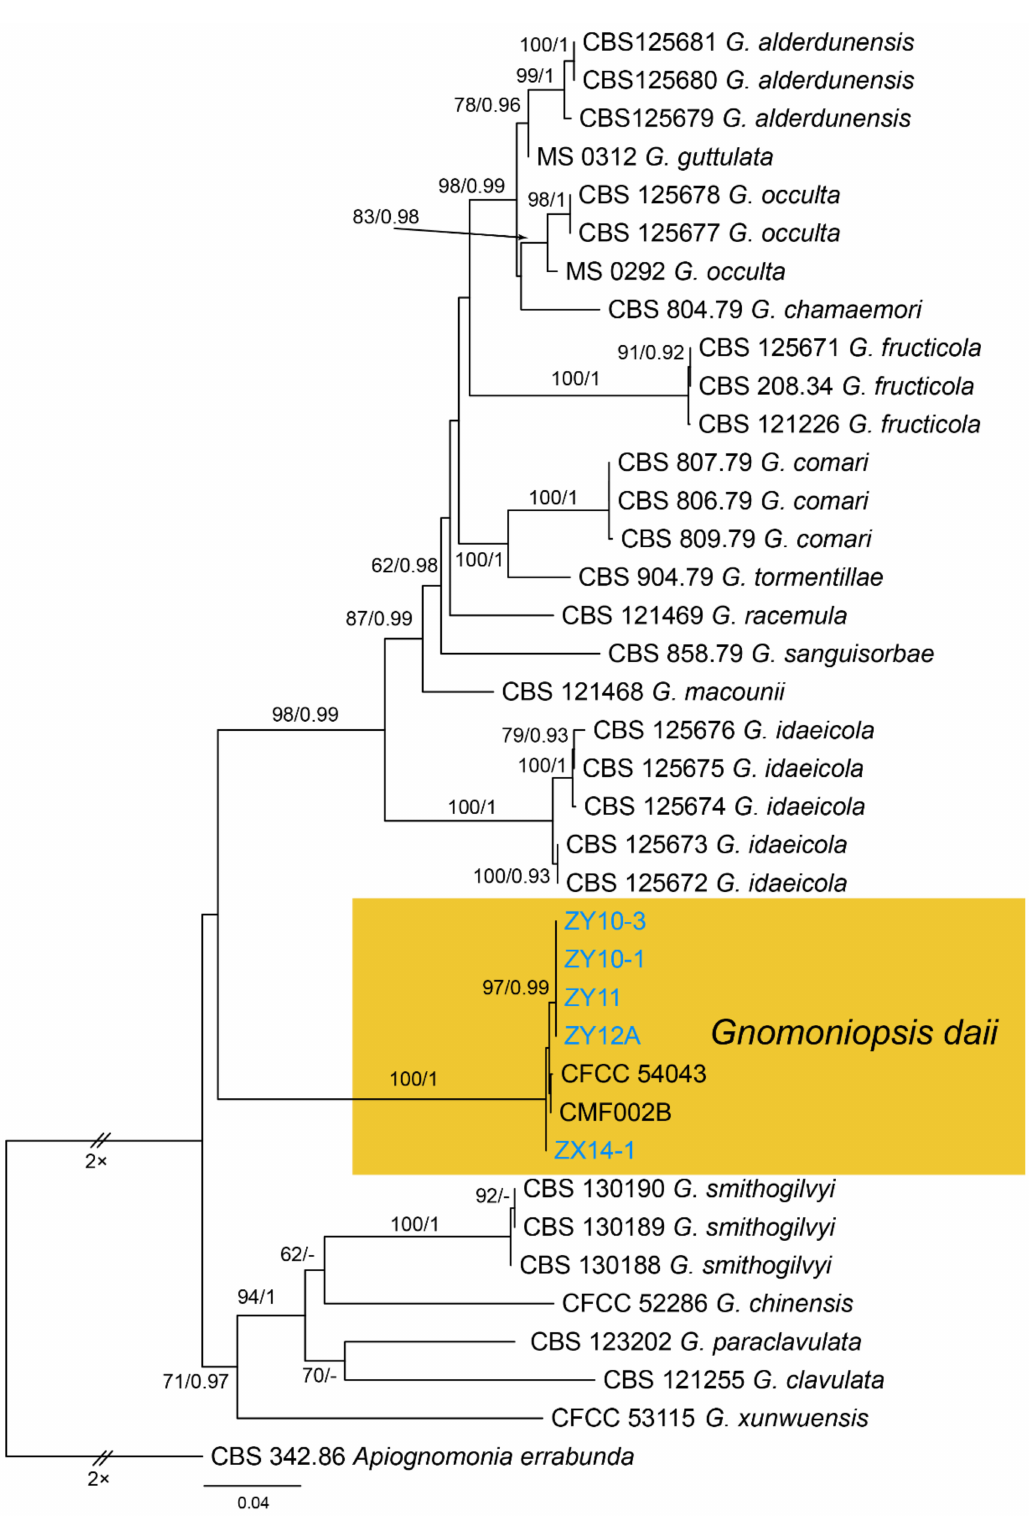
Figure A10. Phylogram generated from RAxML analysis based on combined ITS, tef1 and tub2 sequence data of Gnomoniopsis isolates. The tree was rooted to Apiognomonia errabunda (CBS 342.86). The scale bar indicates 0.04 nucleotide changes per site. Isolates from this study are marked in blue, and the identified species is marked in